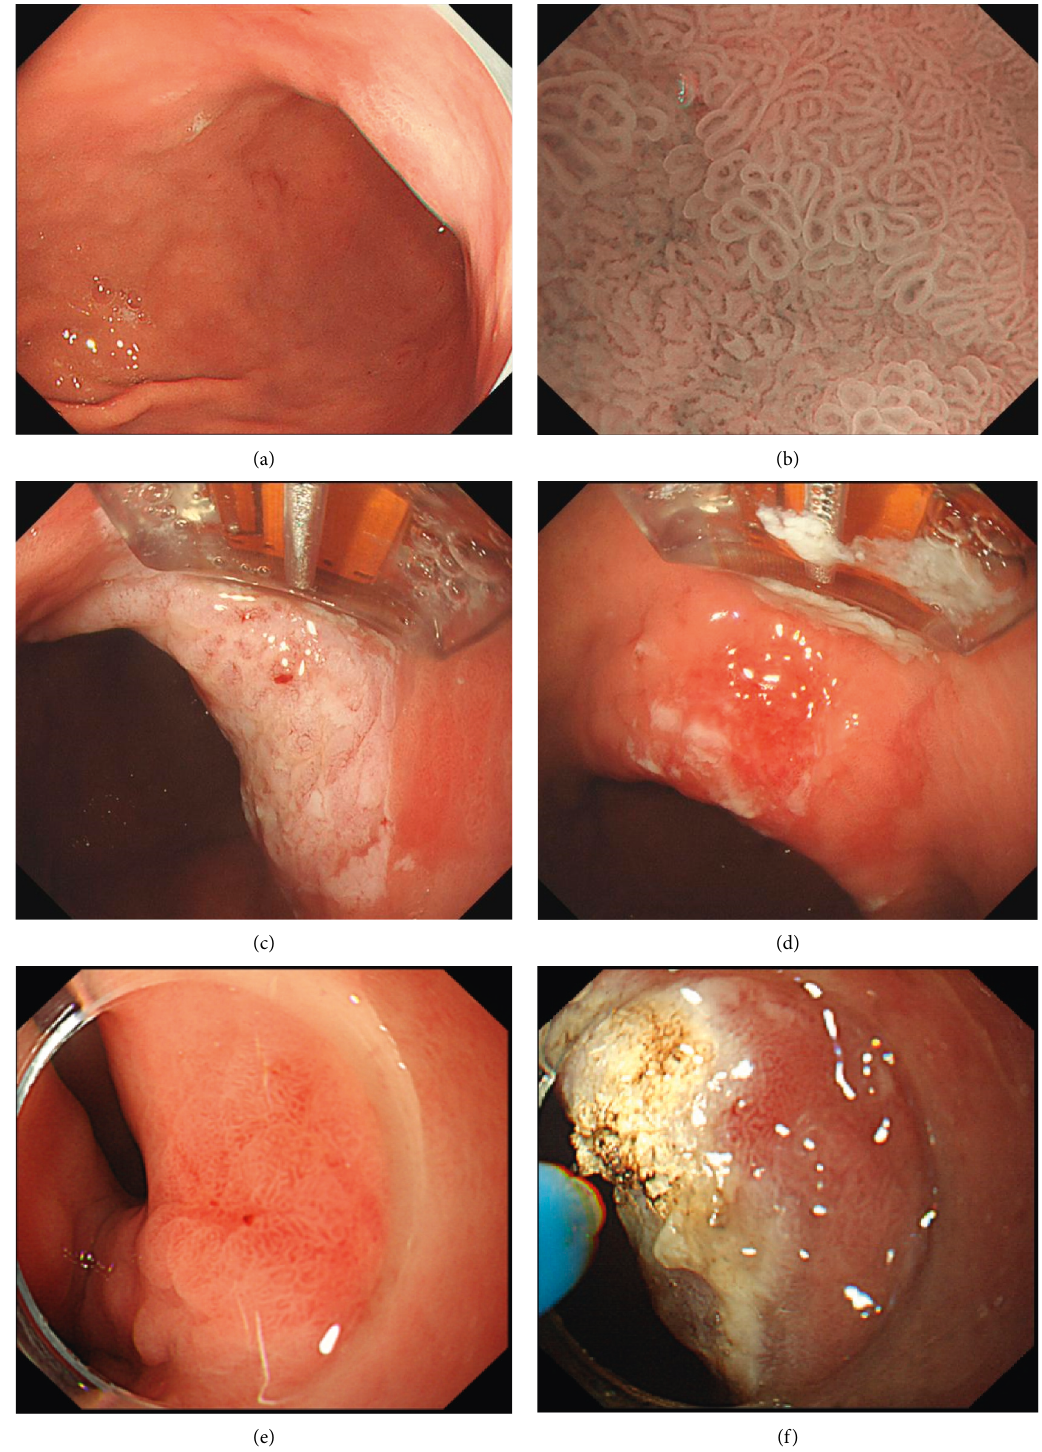
Figure 1: Radiofrequency ablation and argon plasma coagulation procedures for gastric low-grade intraepithelial neoplasia. (a) White-light imaging of the lesion. (b) Magnifying endoscopy with narrow-band imaging of the lesion (strong magnification). (c) After ablation, the surface of the lesion showed white coagulation and necrosis. (d) After scraping off the necrotic mucosal tissue on the surface. (e) White-light imaging of another lesion (reversed view). (f) After argon plasma coagulation, the surface of the lesion showed light yellow and brown-black coagulation and